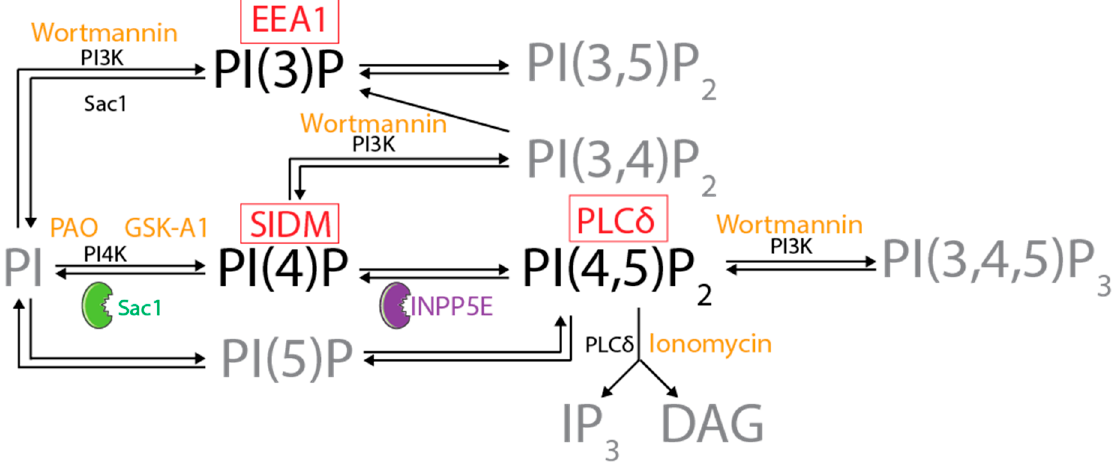
Figure 1. Diagram representing the pathway by which the different phosphorylated forms of phos- phatidylinositol are interconverted. The kinase and phosphatase reactions are indicated with black arrows. The two enzymes (Sac1 and INPP5E) used in this study are shown in green and purple. Sac1 dephosphorylates PI(4)P into PI, and inositol polyphosphate 5-phosphatase E (INPP5E) converts PI(4,5)P 2 to PI(4)P. The inhibitors and drugs used to manipulate specific reactions are indicated in orange on top of the affected enzyme. These included ionomycin that depletes PI(4,5)P 2 , phenyl arsine oxide and GSK-A1 that deplete PI(4)P, and wortmannin that depletes PI(3)P [32–34] . The biosensors used to mask specific lipids are shown in red boxes on top of the lipid they each bind. These included the PI(4)P binding protein P4M-SidMx2 (SIDM), the PI(3)P-biosensor EEA1 (EEA1), and the PI(4,5)P 2 -biosensor PLC δ -PH (PLC δ ). For convenience, only reactions and lipid species ma-